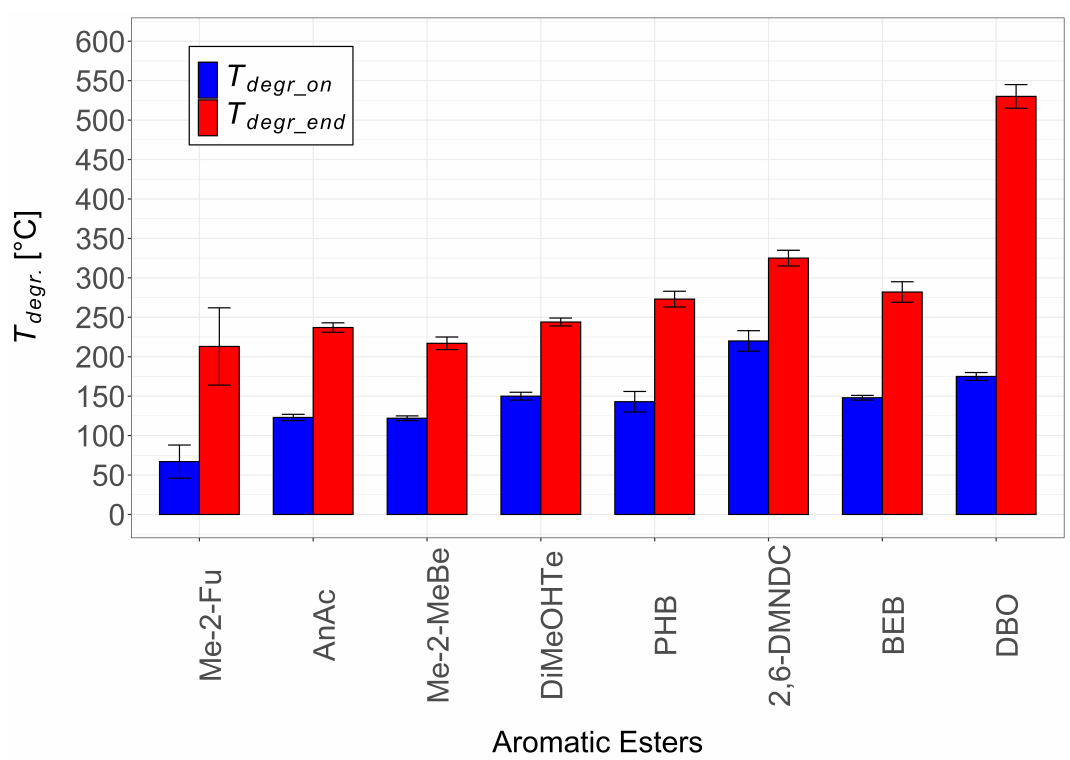
Figure 4. Barplot showing the onset degradation temperature ( T degr onset , blue bar) and endset degradation temperature ( T degr endset , red bar) of the aromatic esters presented. The aromatic esters are ordered according to increasing carbon number. A trend correlating the degradation temperatures to the carbon number seems to arise, with the exception of BEB, which undergoes thermal degradation at lower